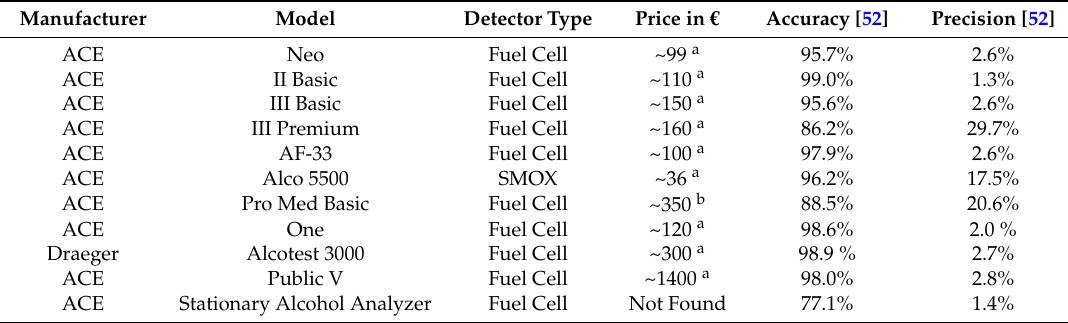
Table 3. The table shows a comparison of different accuracies/precisions to price/detector